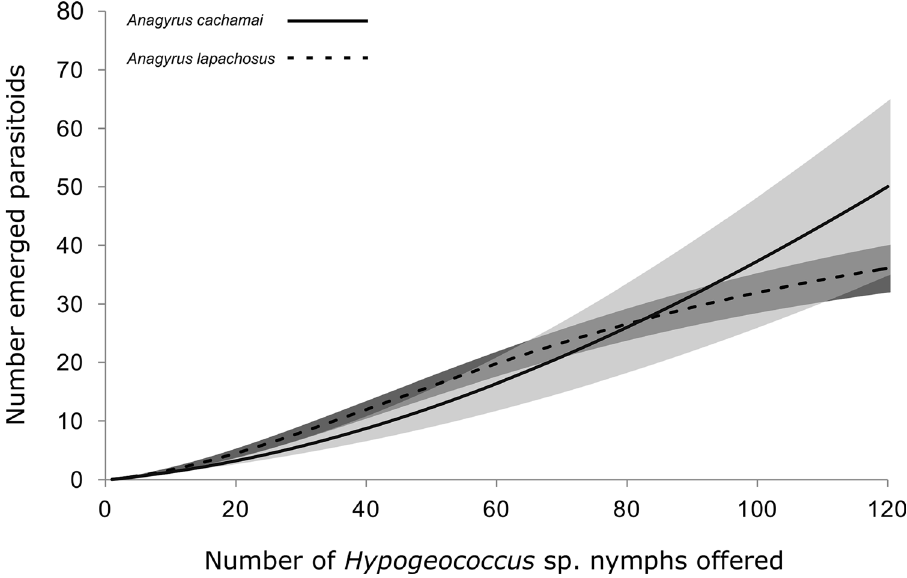
Figure 3. Observed functional response curves of two competing parasitoid species, Anagyrus cachamai and A. lapachosus , attacking Hypogeococcus sp. nymphs. The black line represents the average estimated functional response for A. cachamai and the dotted line for A. lapachosus . The light gray area indicates the credibility interval for the estimated functional response of A. cachamai , and the dark gray area shows the credibility interval for A. lapachosus